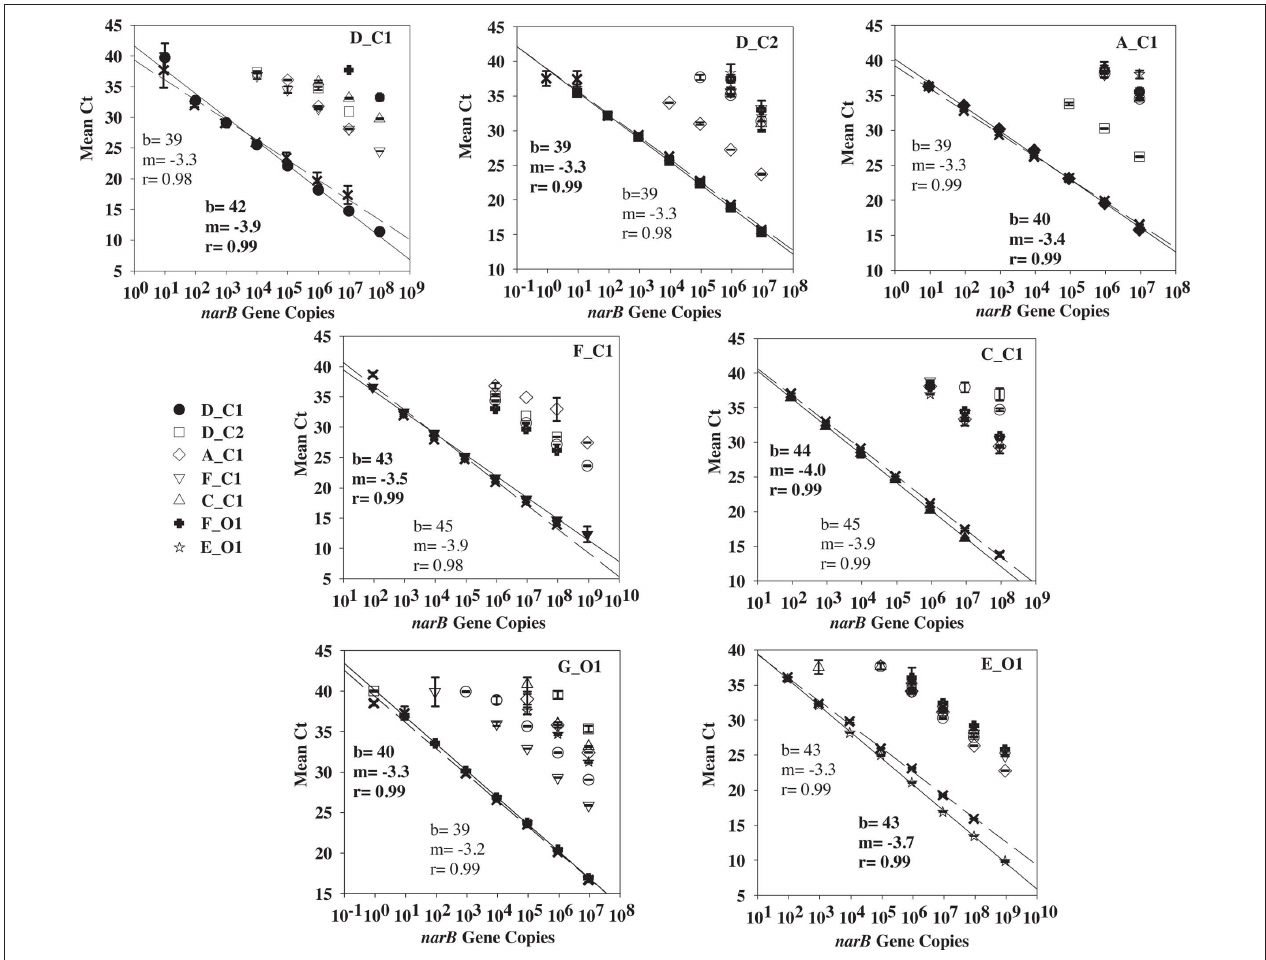
FiguRe 3 | Cross-reactivity tests for each narB qPCR assay using target and non-target plasmid standards (listed in Table 1). Target standard data are the solid symbols (X’s are secondary qPCR runs) and include a linear fit line (solid line for solid symbols, dashed line for X’s). Linear fit data in bold corresponds to